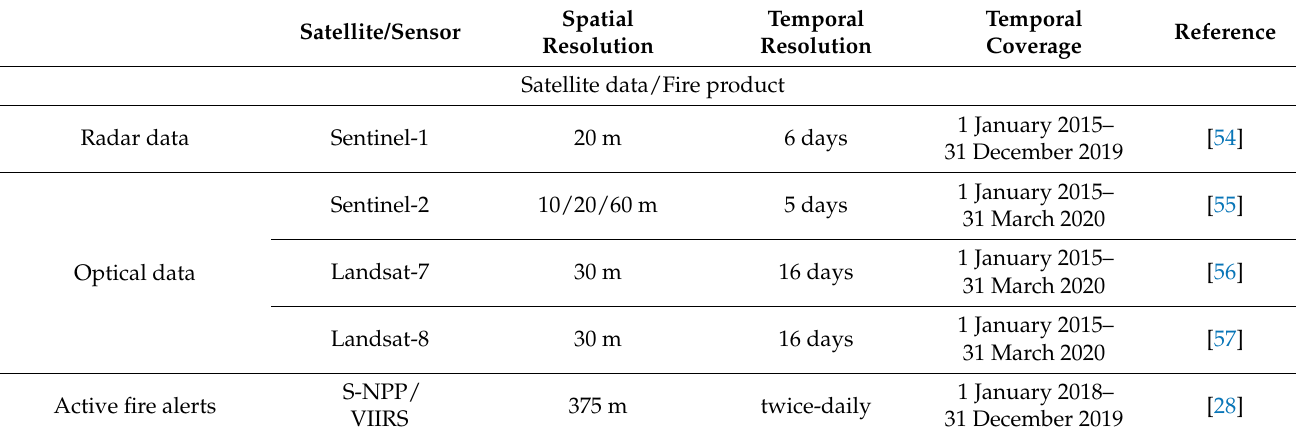
Table 1. Overview input